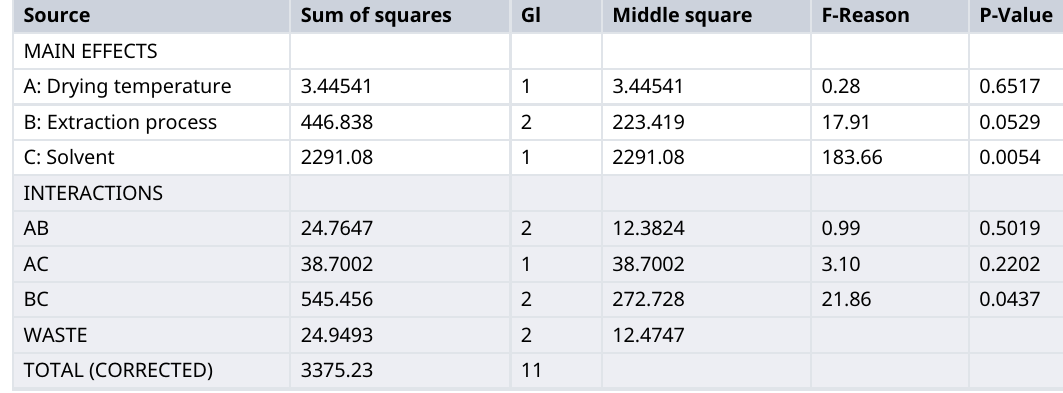
Table 3. Analysis of variance for extraction yields of Croton